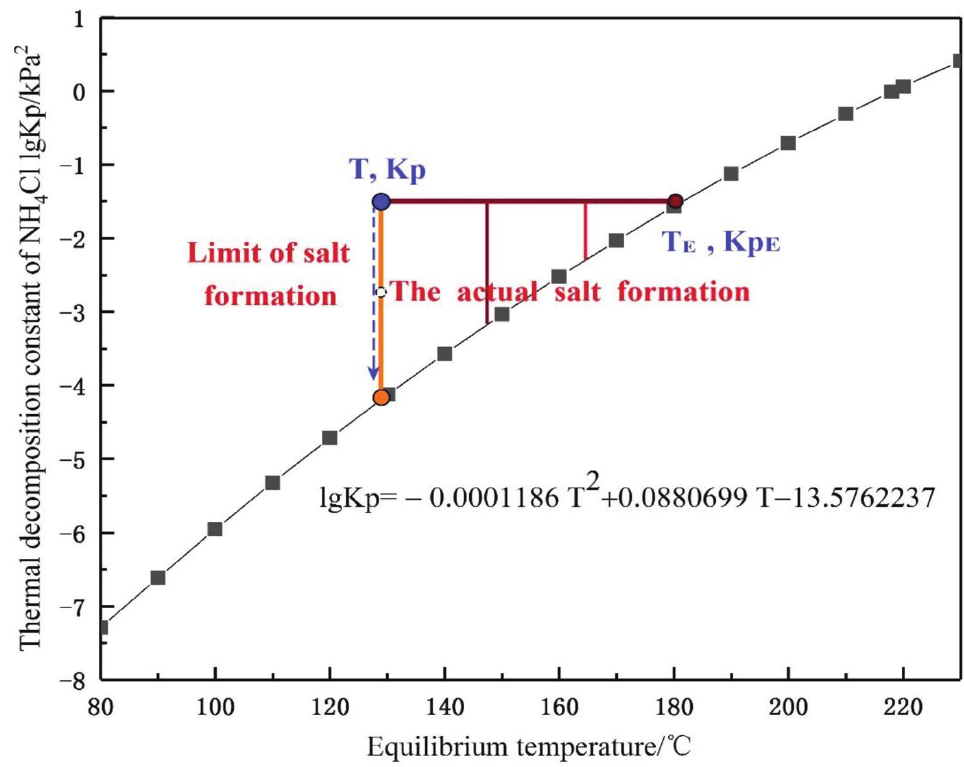
Figure 8. Crystal equilibrium curve of ammonium